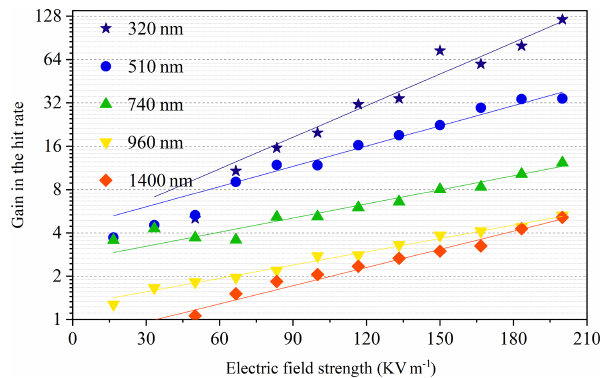
Figure 3. The gain in the hit rate achieved for different sizes of PSL particles plotted over the extraction electric field strength.